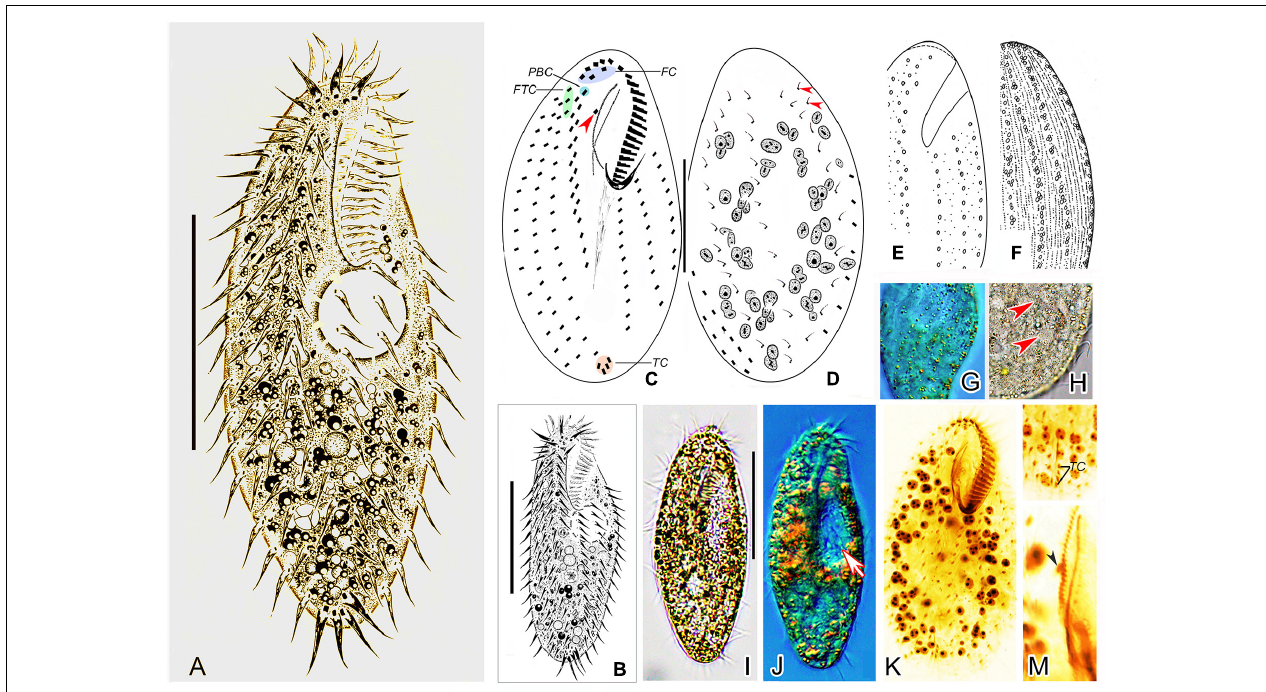
FIGURE 2 | Morphology of Metaurostylopsis alrasheidi n. sp. from life ( A,B,E,F,H,I , bright field; G,J , differential interference contrast) and after protargol preparation (C,D,K–M) . (A,B) Ventral views showing representative individuals. (C,D) Ventral (C) and dorsal (D) views, arrowhead in (C) indicates the buccal cirrus, arrowheads in (D) mark the extra dorsal bristles. (E–H) Arrangement of cortical granules on ventral (E,G) and dorsal (F,H) side, arrowheads in (H) indicate small cortical granules. (I,J) Ventral views of different individuals, arrow in (J) shows the contractile vacuole. (K) Ventral view of the holotype specimen to show the ciliature and nuclear apparatus. (L) Showing the J-shaped transverse cirri. (M) Details of the undulating membranes, arrowhead indicates the buccal cirrus. FC, frontal cirri; FTC, frontoterminal cirri; PBC, parabuccal cirrus; TC, transverse cirri. Scale bars = 40 µ m.